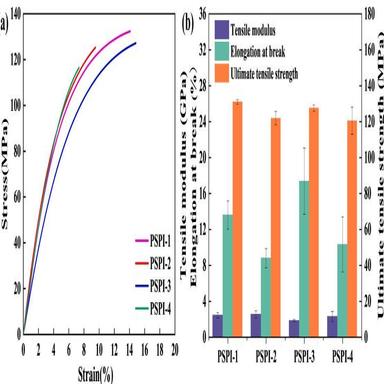
(a) The stress-strain curves of PSPIs, (b) The mechanical behaviors of PSPIs.